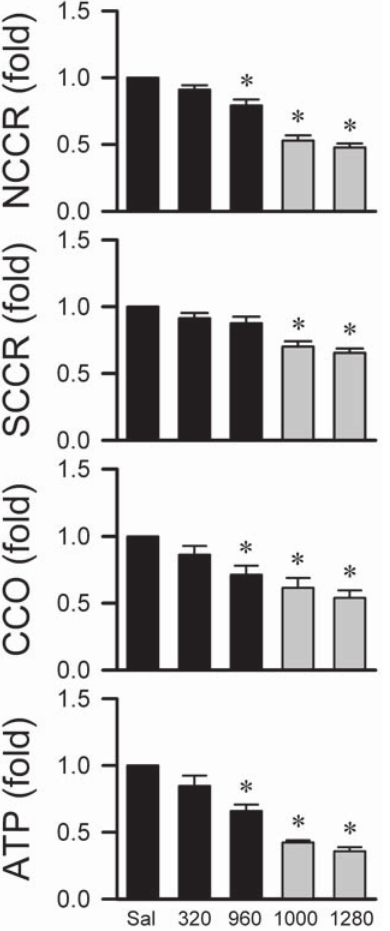
Figure 4. Bioenergetic failure accounts for the loss of functional integrity in RVLM. Fold changes against saline-control group in enzyme activity of NADH cytochrome c reductase (NCCR), succinate cytochrome c reductase (SCCR) or cytochrome c oxidase (CCO) and ATP production in mitochondria isolated from ventrolateral medulla of rats that received intravenous administration of Mev at sub- lethal (320 or 960 m g/kg) or lethal (1000 or 1280 m g/kg) doses. Values are mean 6 SEM of quadruplicate analyses from samples pooled from 5– 7 animals per experimental group. * p , 0.05 versus saline group in the post hoc Scheffe´ multiple-range analysis following one-way ANOVA.